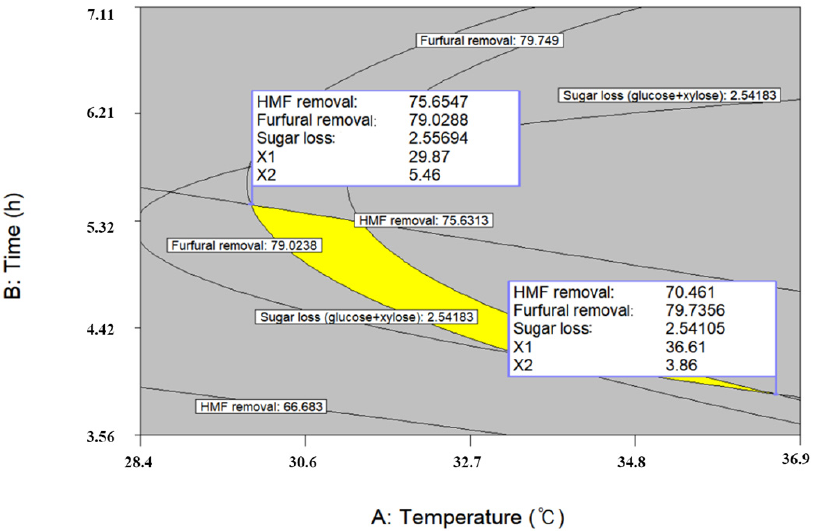
Figure 4. Superimposing contour map of optimized conditions for the maximum removal of HMF and furfural with the minimum sugar loss in APH of S. obliquus .